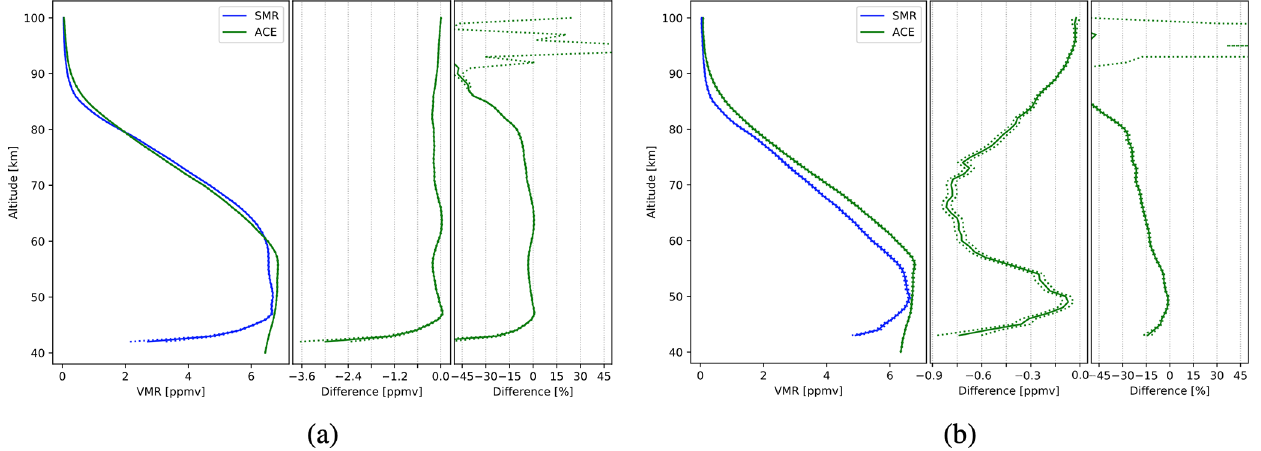
Figure 10. Comparison of SMR H 2 O profiles, from FM13 (a) and FM19 (b) , with those from ACE-FTS retrievals. The data plotted are global averages over the period between February 2004 and April 2019. Figure characteristics are the same as in Fig.